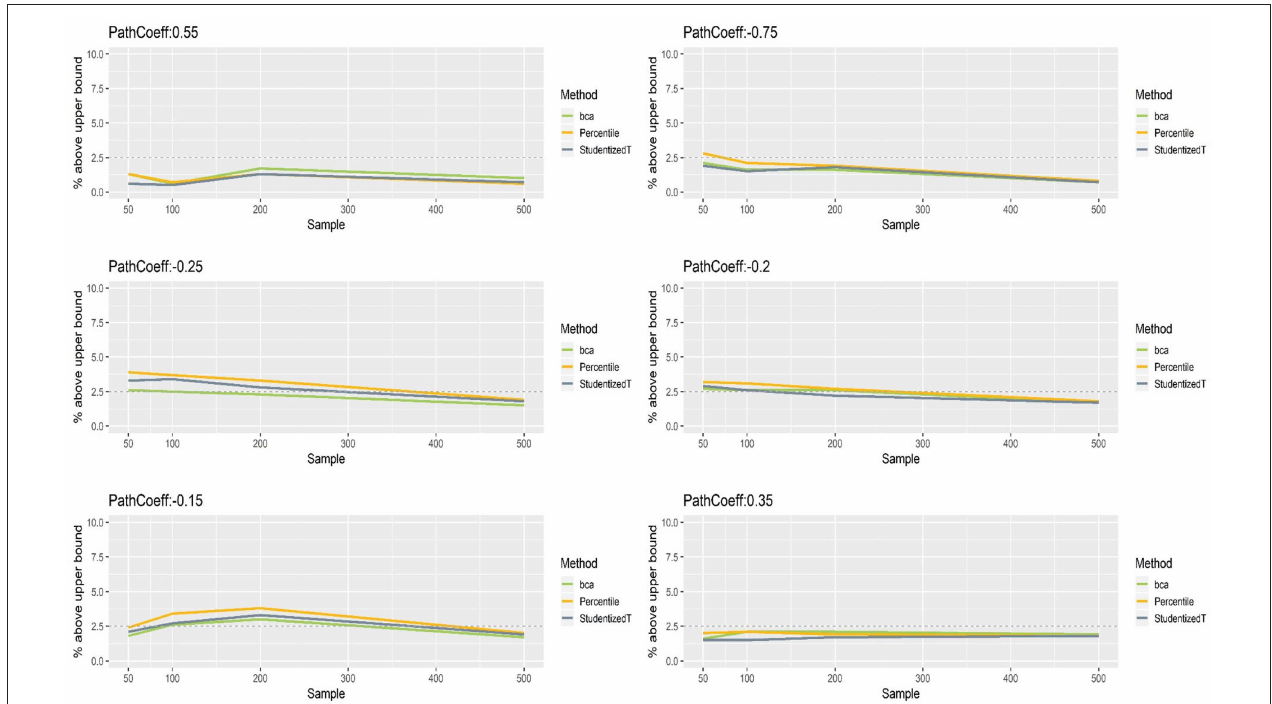
FIGURE 6 | The upper limits of percentile, bias-corrected and accelerated bootstrap (BCa), and Student’s t 95% confidence intervals (CIs) of path coefficients in the normal indicator condition.